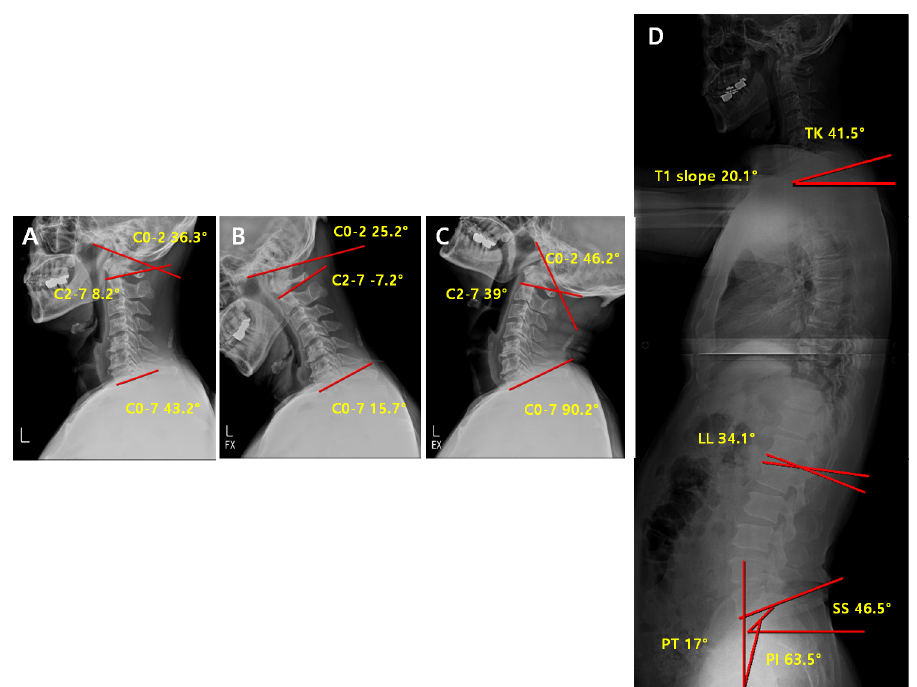
Figure 8. Pre-operative radiological parameters in the reducible non-lordosis group. Cervical spine lateral X-ray of neutral ( A ), flexion ( B ), extension ( C ) and whole-spine lateral X-ray ( D ).